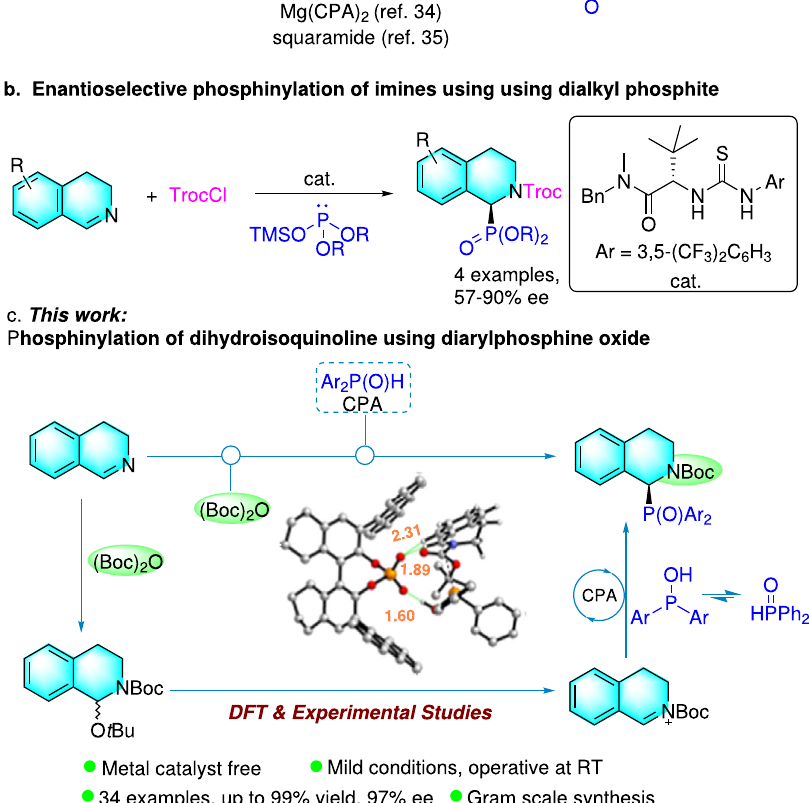
Fig. 1 Works on phosphinylation of imines and 3,4-dihydroisoquinolines. a , b Previous works on enantioselective phosphinylation of imines. c This work on phosphinlylation of dihydroisoquinoline using diarylphosphine